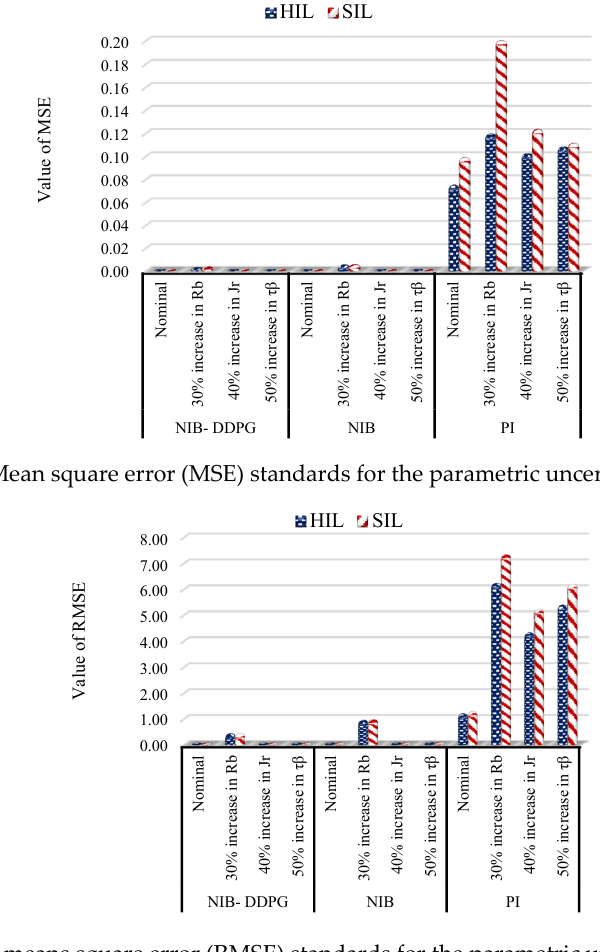
Figure 14. Comparison of mean square error (MSE) and root mean square error (RMSE) standards for the parametric uncertainties.